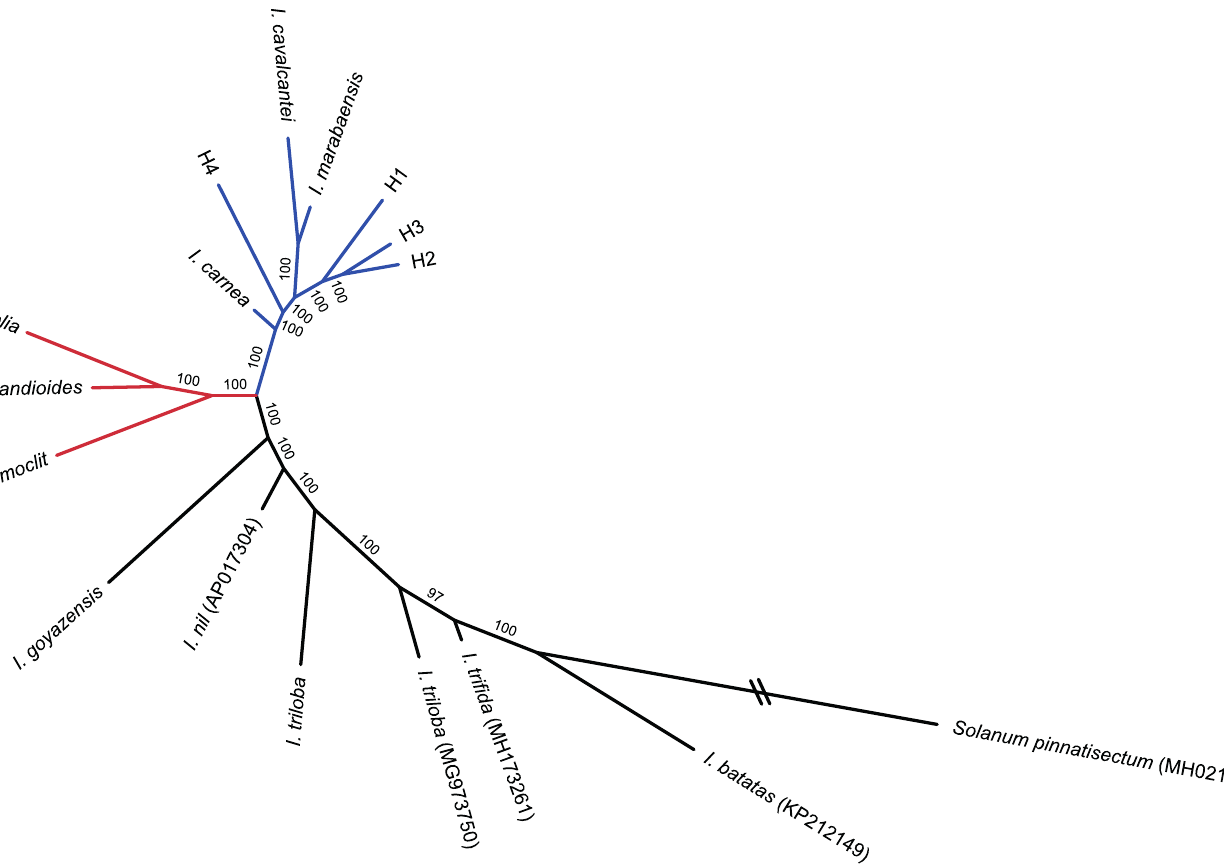
Fig 5. Dendrogram representing the genetic distances among Ipomoea species. Unrooted genetic distance tree based on k-mer frequency distribution using the AAF approach, using the 12 Ipomoea sequenced plastomes, four Ipomoea plastomes previously available in public databases and one outgroup from Solanales ( Solanum pinnatisectum ). The cavalcantei-marabaensis group is highlighted in blue and the quamoclit-asarifolia-maurandioides in brown.